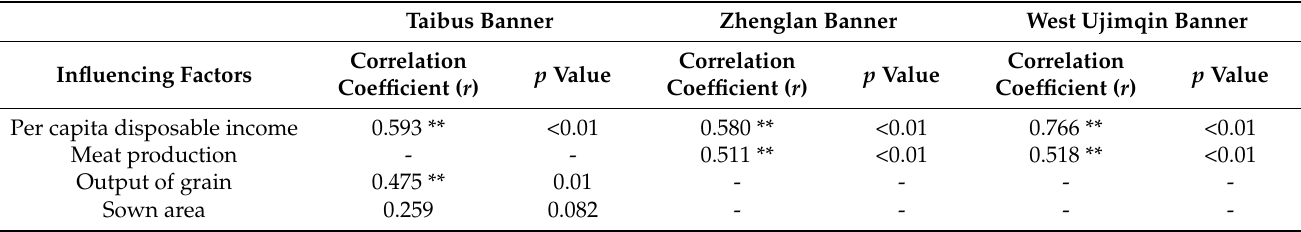
Table 3. Correlations between per capita food consumption and several influencing factors. - represents that the data of factor in banner was too little to show correlation with per capita food consumption, ** represents significant at 1% level. Taibus